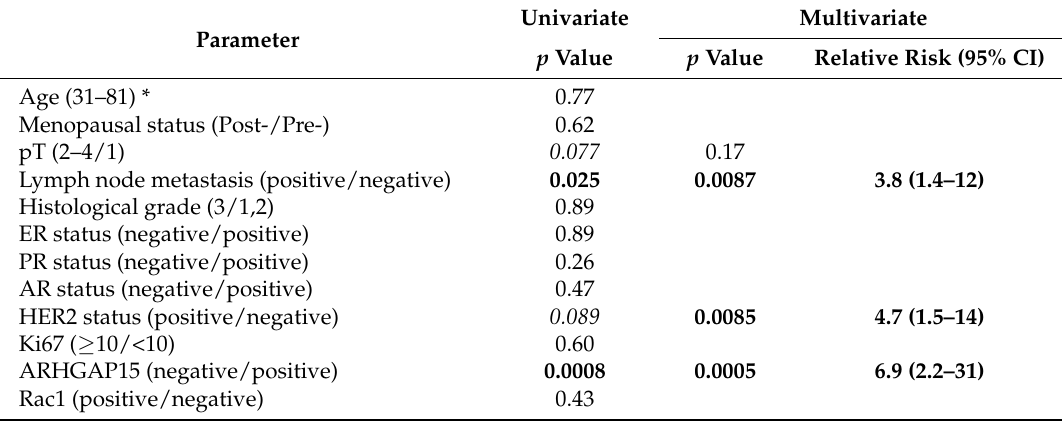
Table 3. Univariate and multivariate analyses of disease-free survival in breast carcinoma patients ( n = 100). Univariate Multivariate Parameter p Value p Value Relative Risk (95% CI)